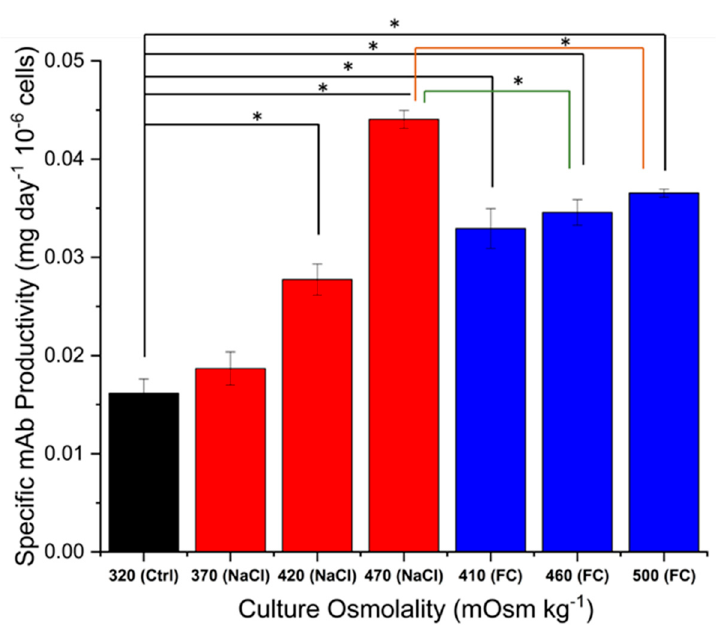
Figure 5. Specific antibody productivity for control, NaCl and Feed C experiments. Error bars represent the standard deviation of two biological replicates. For the analysis of significance (* p < 0.05), equal variance of each variable between different experiments was assumed.